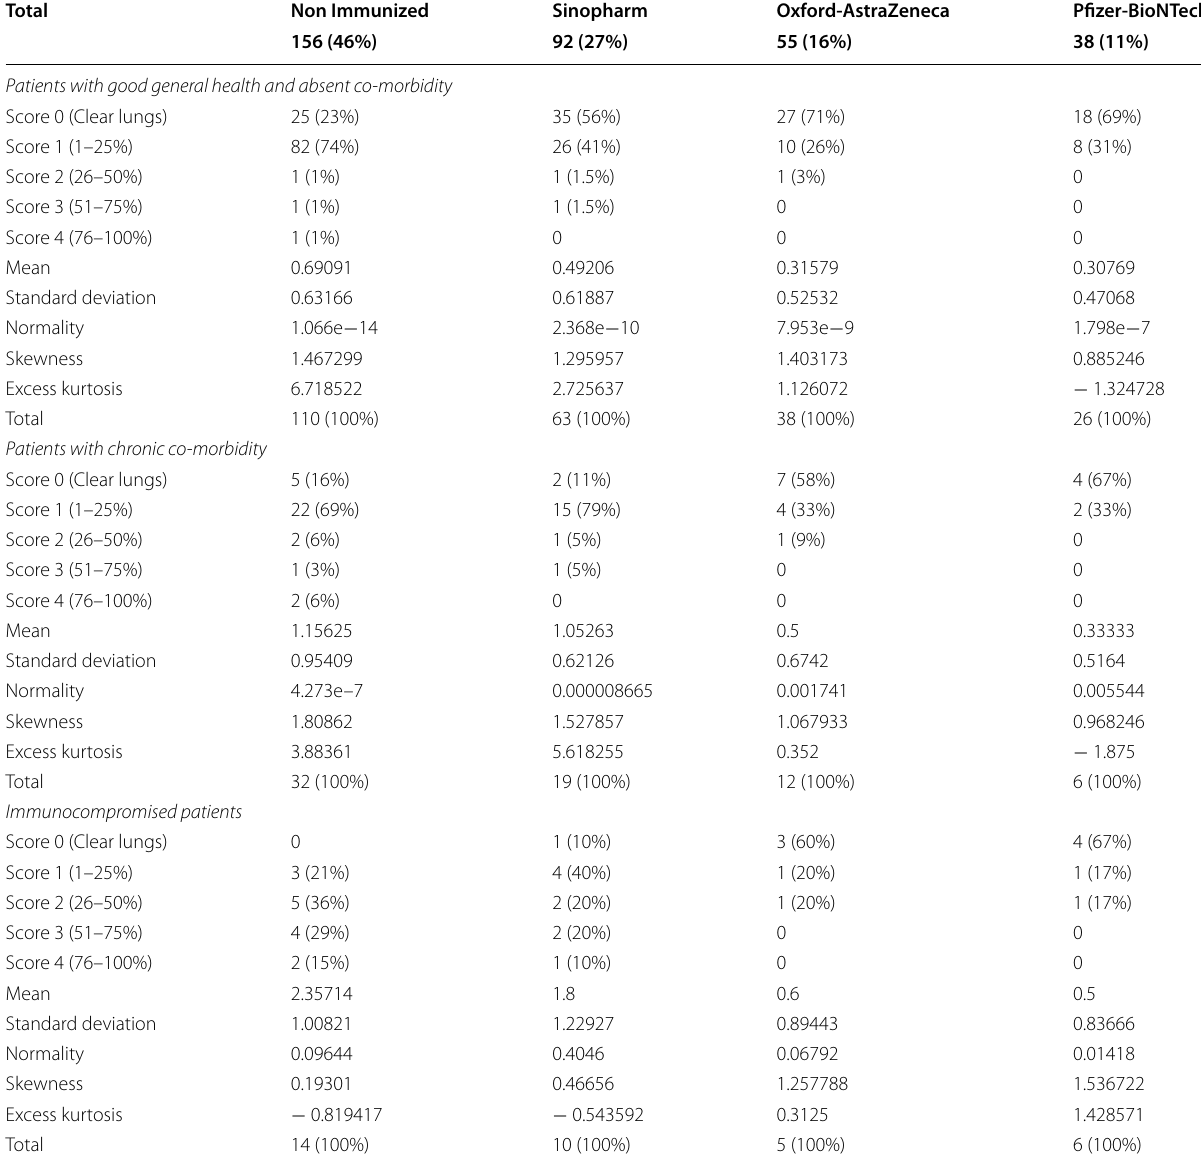
Table 2 CT‑Severity scores in each group of patients according status of immunization and general health with